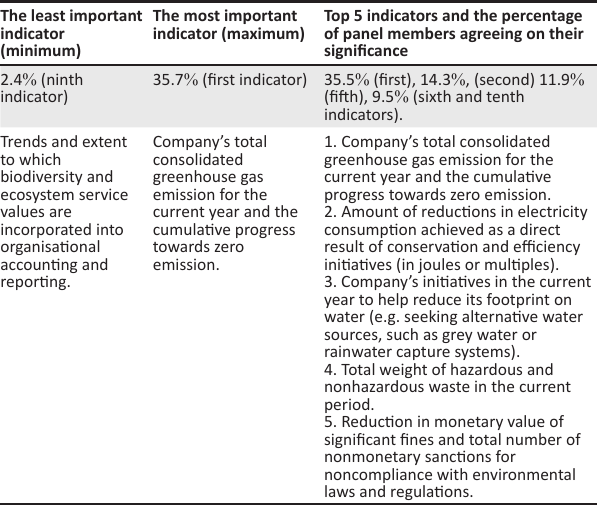
TABLE 2: Environmental pillar indicators from the third round. The least important indicator